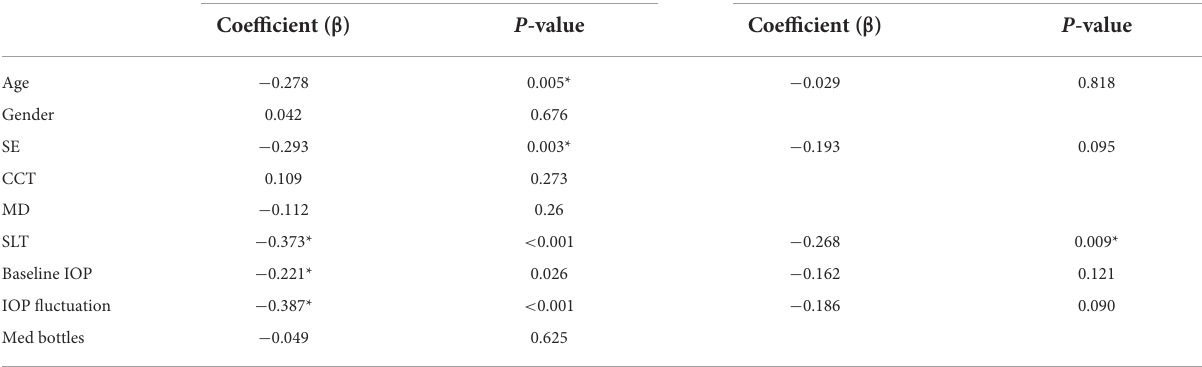
TABLE 2 Correlation between selected variables and 1 IOP (In SLT vs. VF